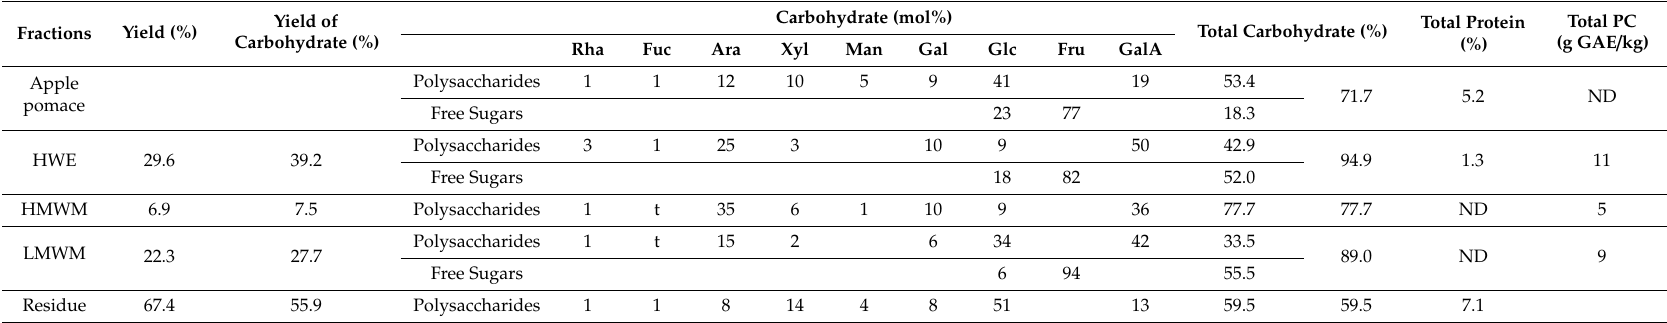
Table 1. Yield (%), monosaccharide (molar%), carbohydrate (%), protein (%), and polyphenolic composition (g gallic acid equivalents (GAE) / kg) of industrial apple pomace, hot water extract (HWE), high molecular weight material (HMWM), low molecular weight material (LMWM), and extraction residue.